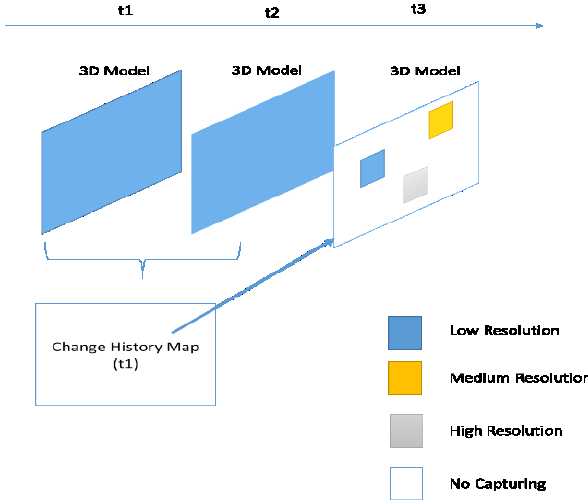
Figure 4. The research approach adopted as regards spatial- temporal